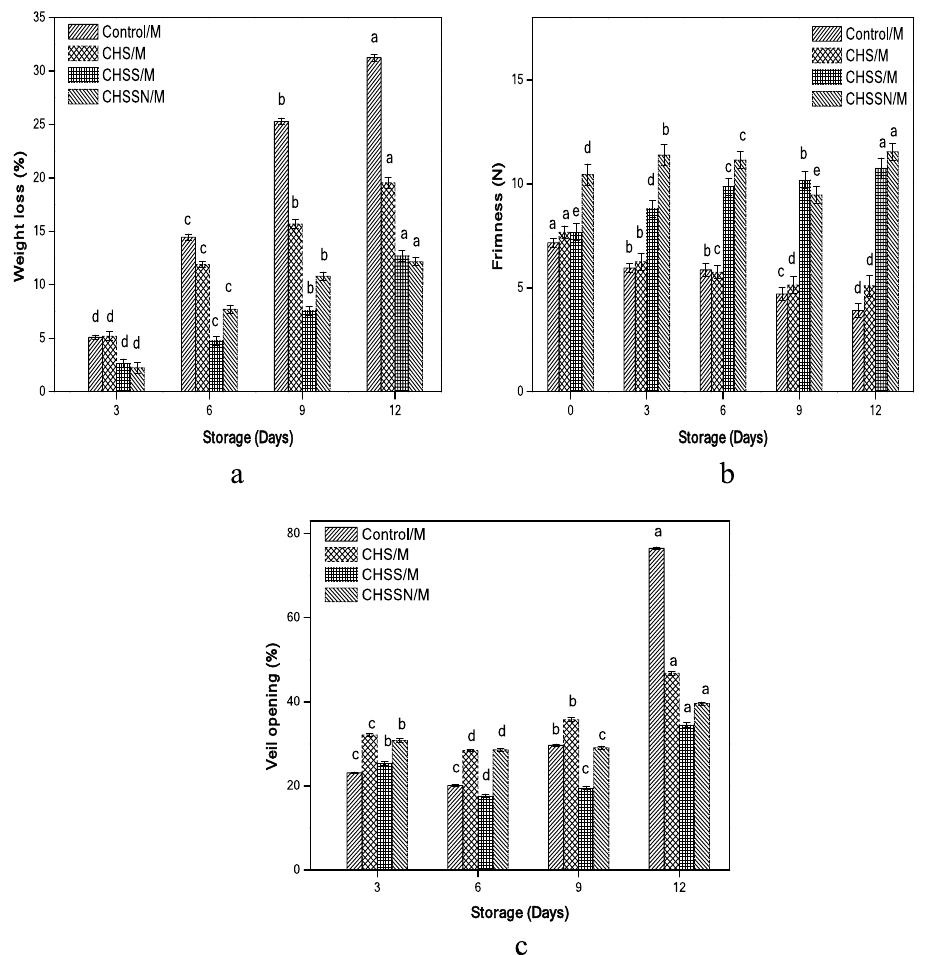
Figure 1. Effects of nano-coating treatments on weight loss ( a ) firmness ( b ), and veil opening ( c